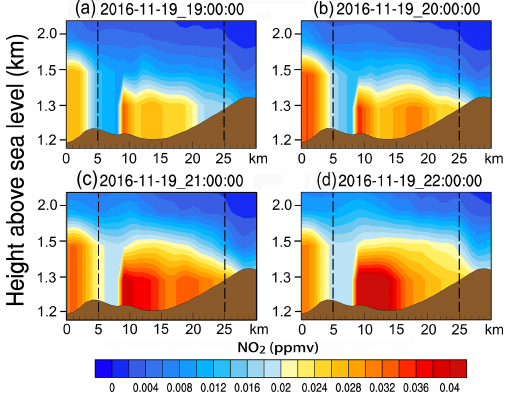
Figure 4. Vertical cross section of hourly NO 2 concentration on the transect across the fine domain (d03) simulated by the control run (S1) at 19:00, 20:00, 21:00, and 22:00UTC on 19 November. The transect is highlighted by the red arrow line in Fig. 2. Terrain height is shown by brown shading, and the x axis indicates the length of the transect (km) across the fine model domain d03 and YWF, bounded by black dashed line, extending from 5 to